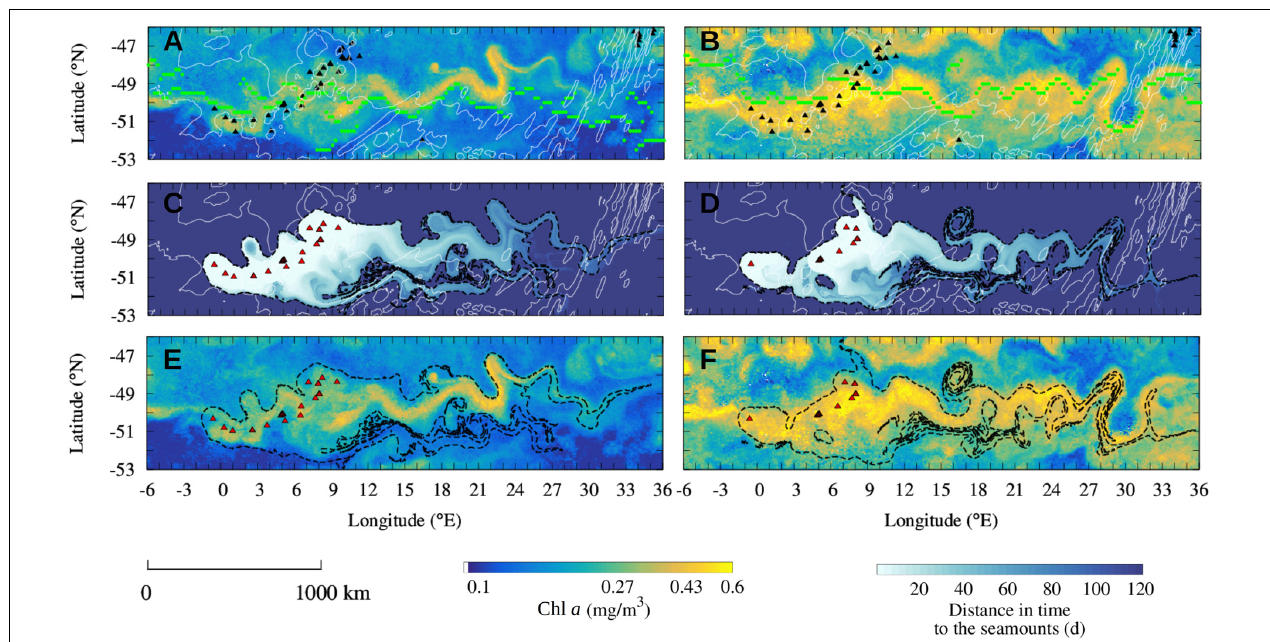
FIGURE 3 | Observation of the seamount mass effect on the Shona Ridge System in February 2004 (A,C,E) and in December 2004 (B,D,F) . (A,B) Observation of Chl a plumes downstream of the shallow seamounts of the SRS (black triangles) in February 2004 (A) and December 2004 (B) . The Chl a plumes spread over thousands of kilometers aligned with the PF current core (green dots). (C,D) Reconstruction of the Lagrangian plumes from the seamounts of the SRS selected for the study periods (red triangles). Black contours indicate the water masses that have been in contact in the 100 days before the blooms event with the selected seamounts. (E,F) Comparison of the Chl a plume observed in the monthly-mean composite images with the Lagrangian plumes estimated from altimetry [black contours extracted from panels (C,D) ]. Shallow seamounts identified in each time period for the Lagrangian analysis are shown in red (C–F) . Isobaths of bottom topography of 3000 m and 4100 m depths are shown in white (A–D) . Note the logarithmic scale for the Chl a